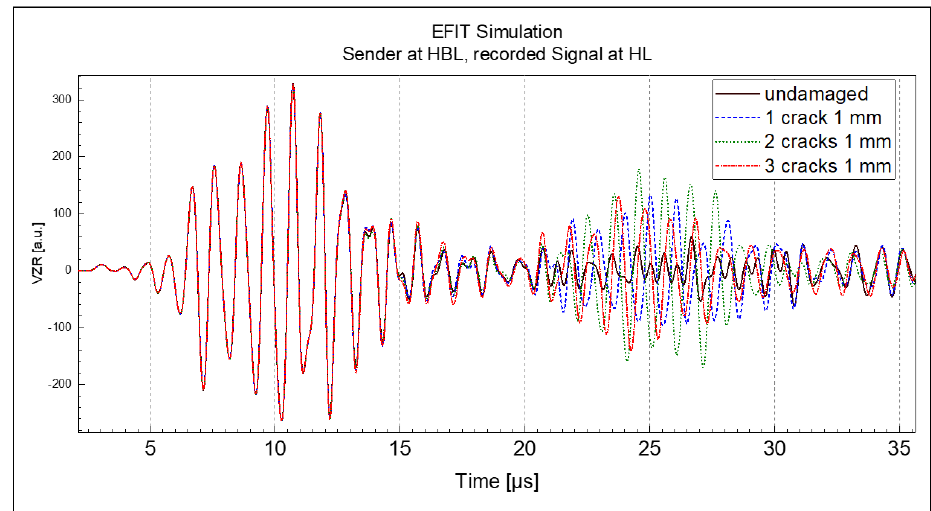
Figure 9. EFIT simulation surface normal velocity signal recorded at HL, crack depth 1 mm.